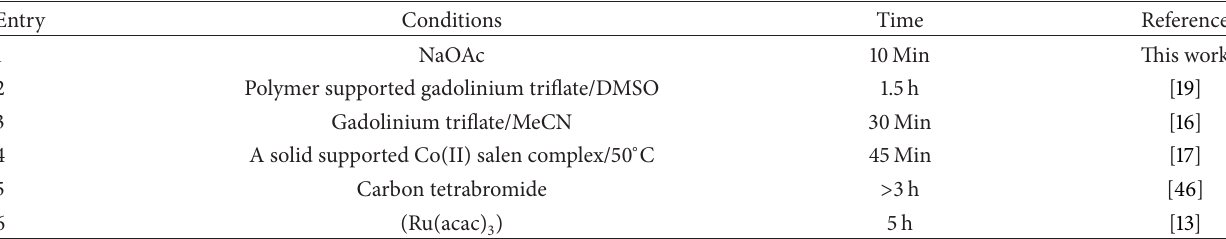
Table 4: Comparison of the procedure with other related